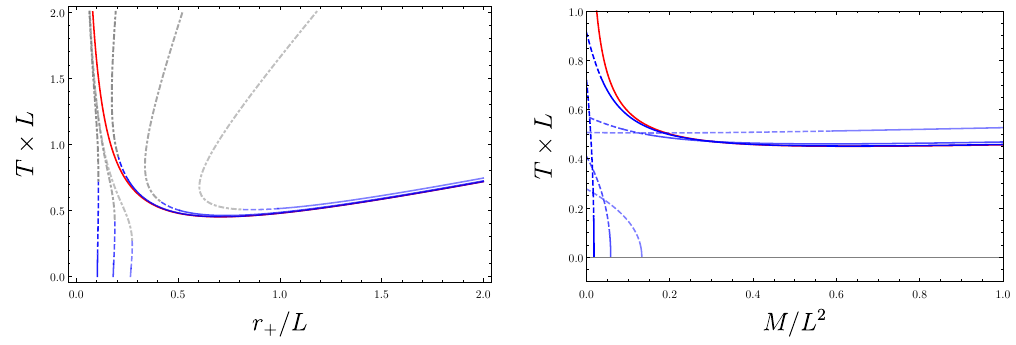
Figure 5 . Properties of five-dimensional uncharged black holes I . Left : a plot of the temperature vs. horizon radius for the five-dimensional black holes. The red curve represents the Einstein 3 , 10 2 , 10 1 / 2 in order of decreasing = 10 gravity result, while the blue curves correspond to µ/µ − − − c opacity (or left to right above and below the red curve). In each case, the dashed portion of the curve indicates negative Wald entropy, while the gray dot-dashed portions indicate that the mass is negative, and hence the solutions do not exist. Right : a plot of the temperature vs. the mass; the curves are the same as in the left plot. For large values of the mass (or, equivalently, large values of the horizon radius) the solutions with the cubic correction hug closely the Einstein gravity curve, while significant differences begin to appear for small values of the mass/horizon radius. Though it is a bit hard to see in the figures, note that the curves that touch T = 0 (those on the bottom left of each figure) always have positive entropy.